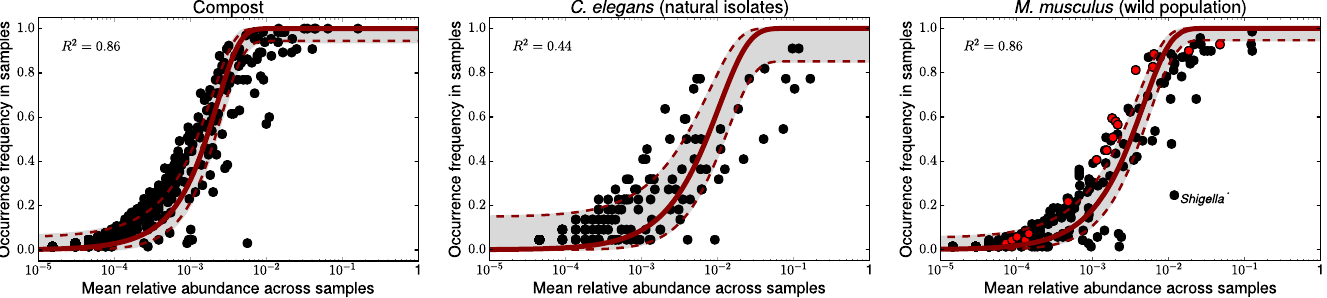
Fig 2. The relationship between mean relative abundance of taxa across all samples and the frequency with which they are detected in individual samples for three representative datasets. Each dot represents a taxon and the solid line is the best-fitting neutral community expectation. The dashed lines and gray area depict the 95% confidence bands. The left panel shows a microbial community sampled from a compost as an example of an abiotic environment. The center panel shows data for the natural microbiota of C . elegans nematode populations sampled from the same compost. The right panel shows the microbiota of a wild M . musculus mouse population. Here, the red dots indicate members of the microbial family Ruminococcaceae, which are predominantly overrepresented compared with the neutral expectation. A genus that was found in much fewer mice than expected by chance is Shigella , being present in less than a quarter of the hosts despite a neutral expectation of nearly 100% prevalence. The OTU abundance data used to generate this figure are available in S6 and S7 Data. OTU, operational taxonomic unit.